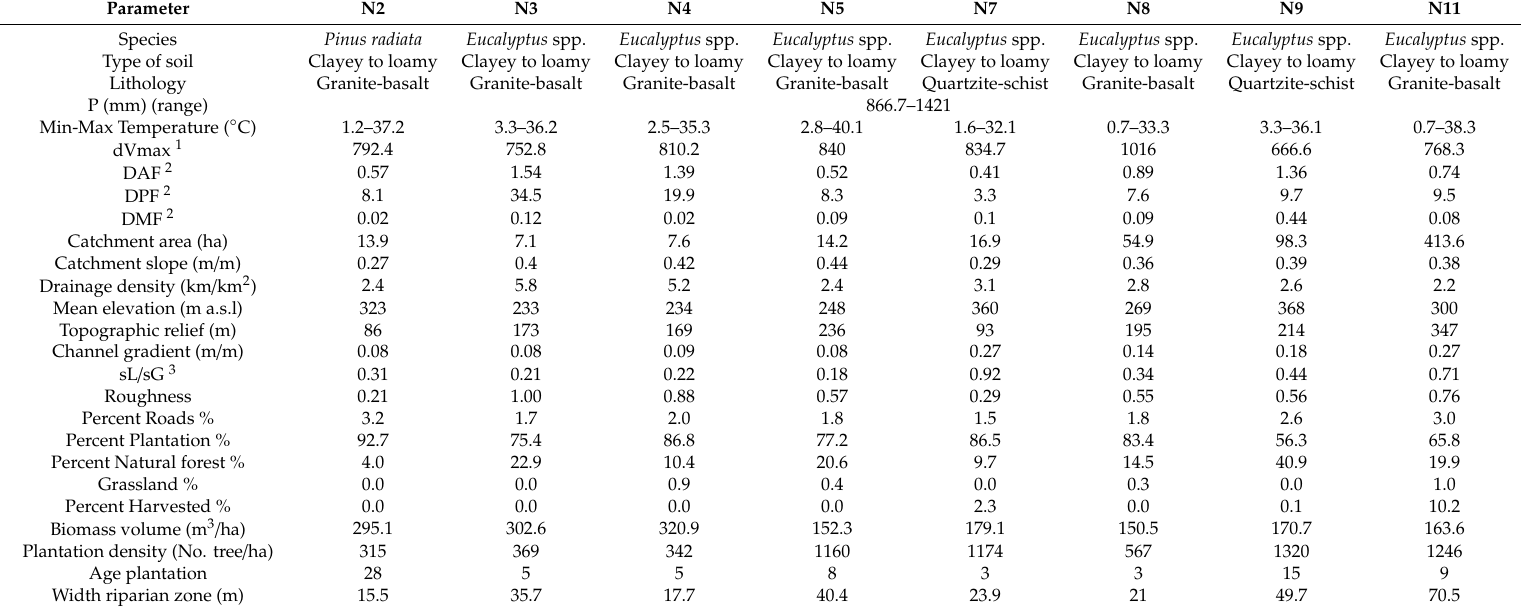
Table 1. Physiographic and land use characteristics of the eight studied catchments (see Figure 1 for location